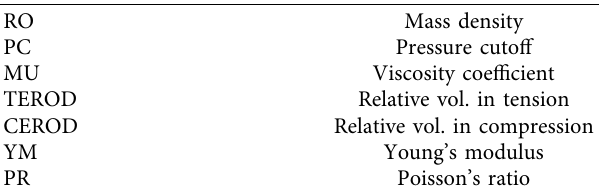
Table 2: Parameters of NULL model.